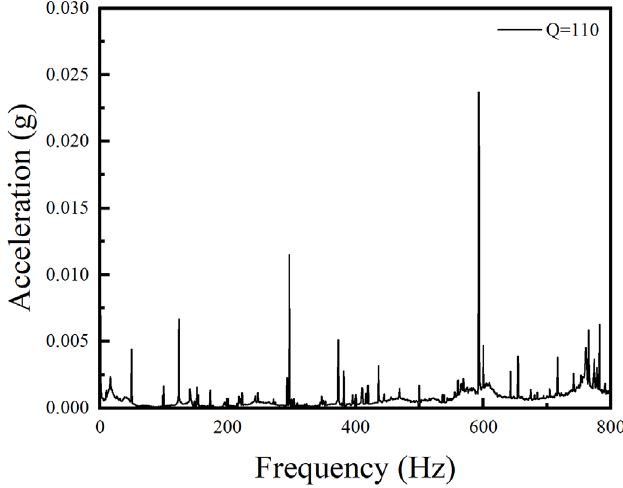
Fig. 21. Spectrogram of vibration response (centrifugal pump speed is about 2955 r/min, fl ow rate is about 110 m 3 /h).